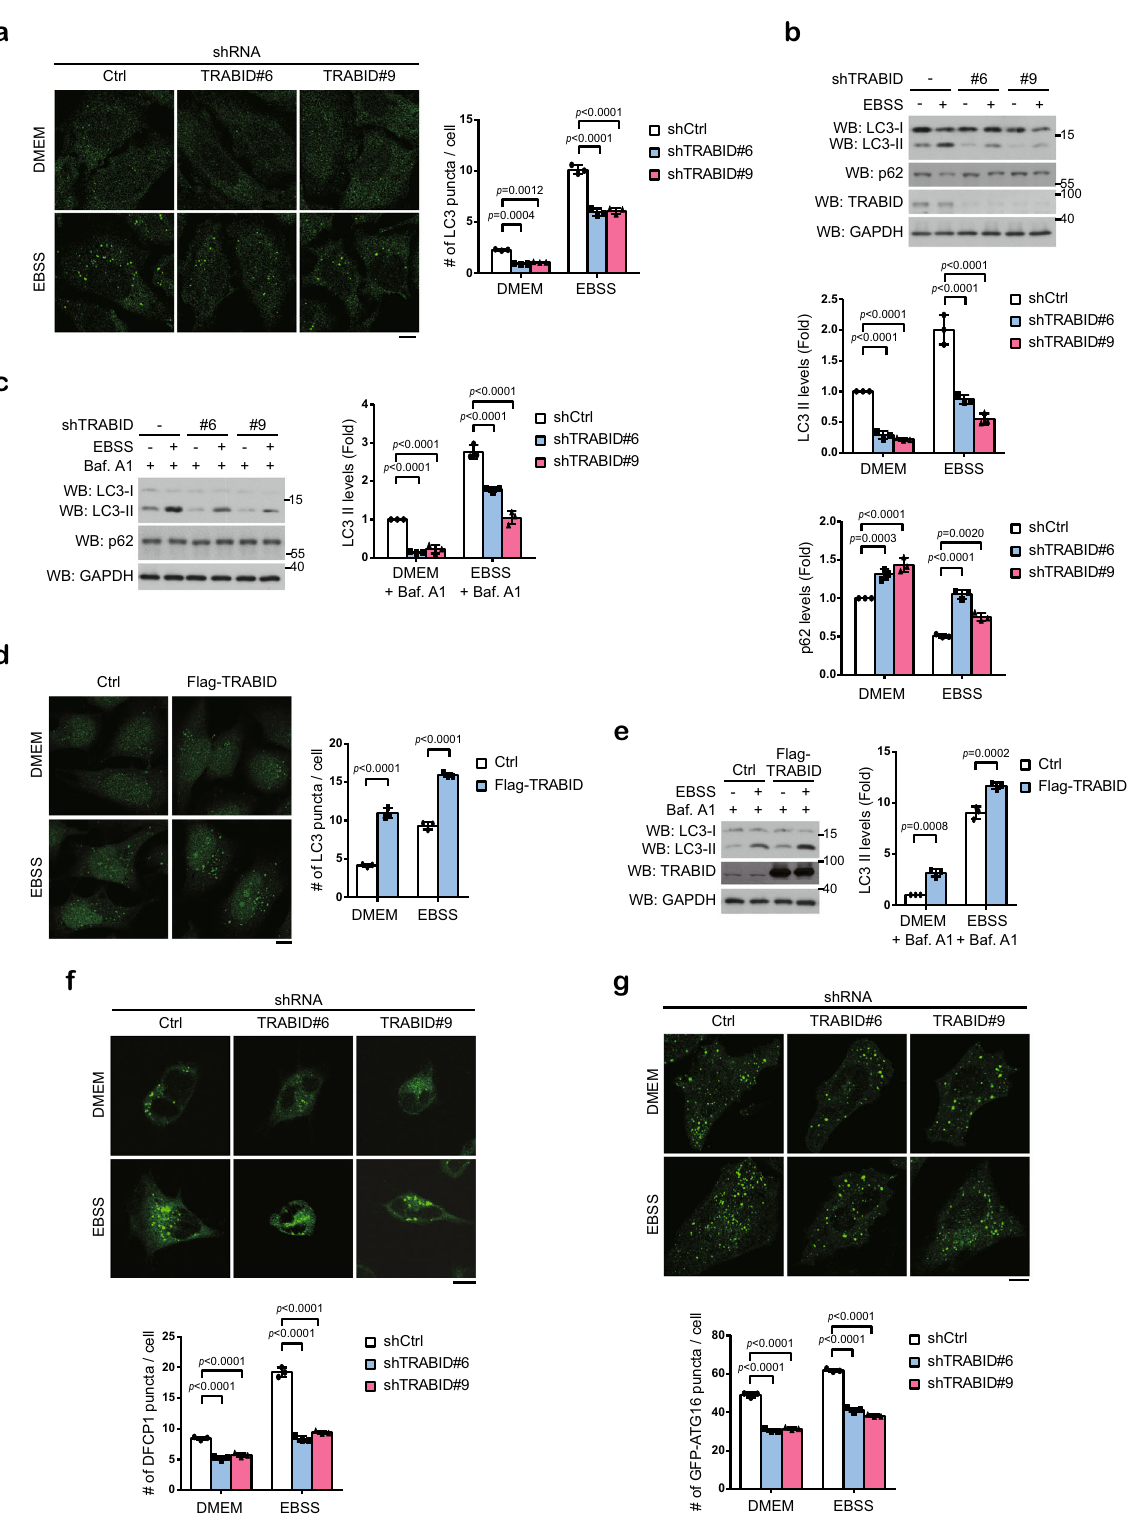
TRABID reduces VPS34 K29/K48 ubiquitination to stabilize VPS34 . Next, we de fi ned the functional position of TRABID in the autophagosome biogenesis process. TRABID knockdown did not affect mTOR, AMPK and ULK1 activities, as monitored by phosphorylation of ribosomal S6 protein, ULK1 S317 residue, and ATG13 S318 residue, respectively (Supplementary Fig. 1b, c). However, TRABID knockdown diminished DFCP1 puncta, NATURE COMMUNICATIONS| (2021) 12:1322